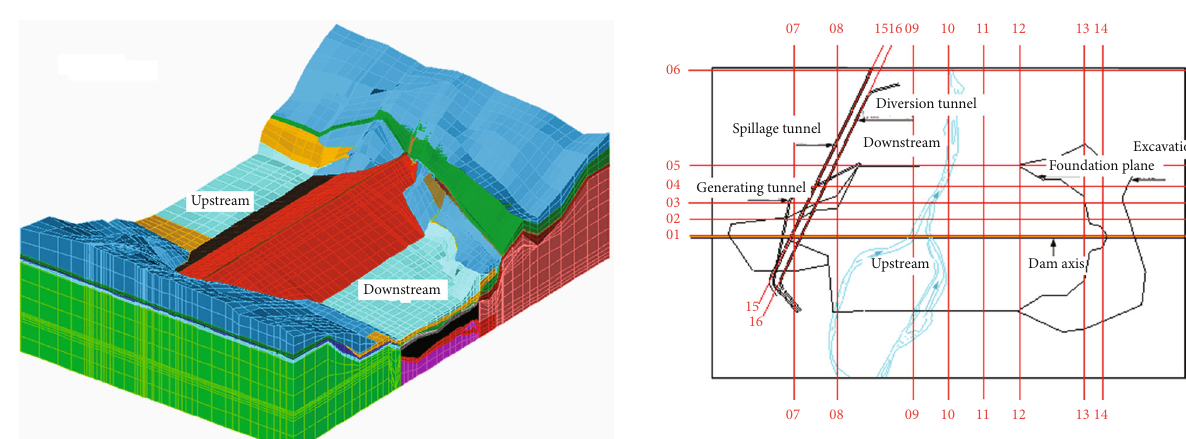
Figure 5: The position and number of a calculative area.